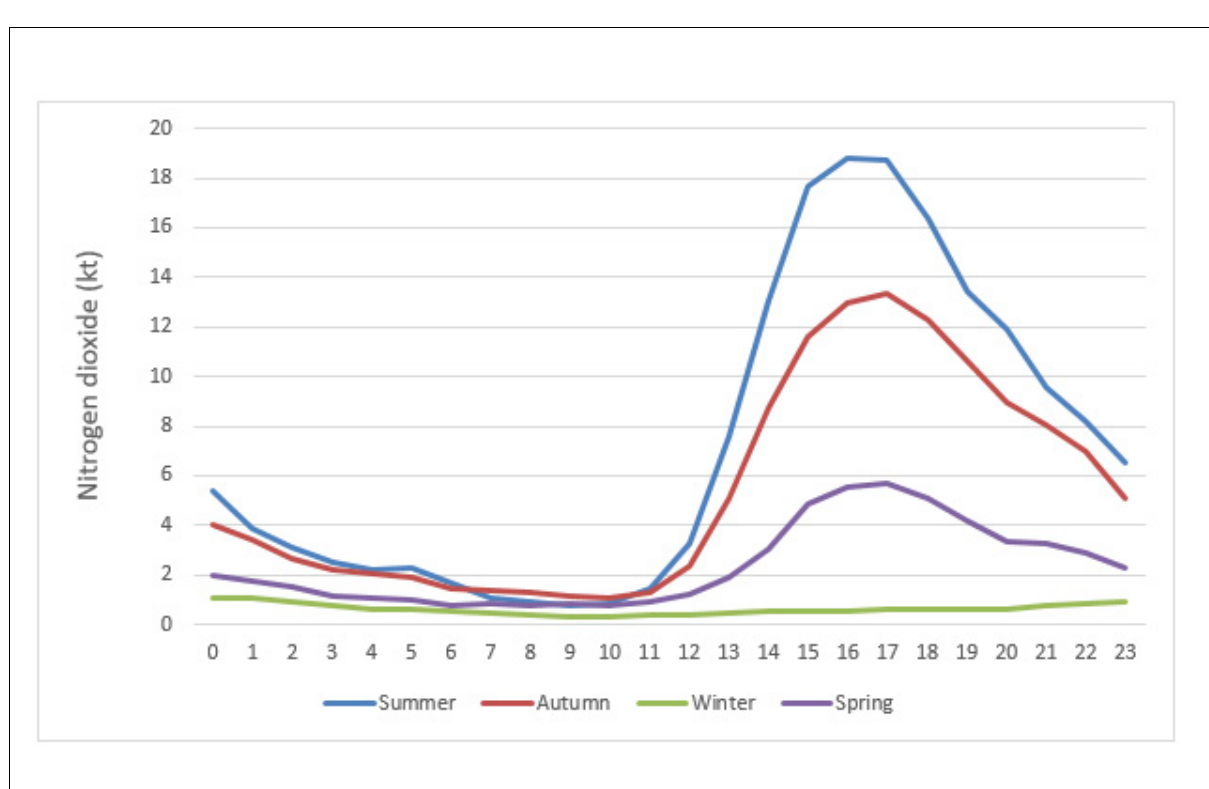
Figure 8: Seasonal diurnal variation of LNOx production over South